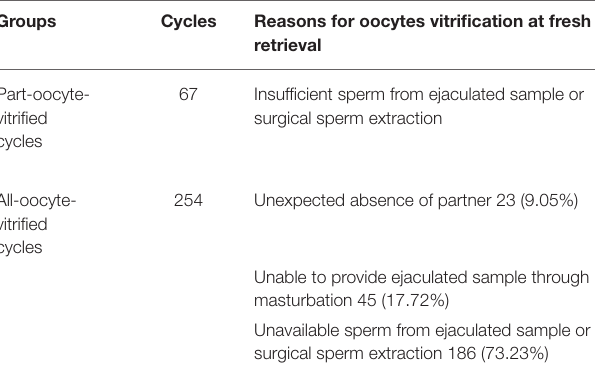
TABLE 1 | Reasons for lack of sperm availability on the day of oocyte